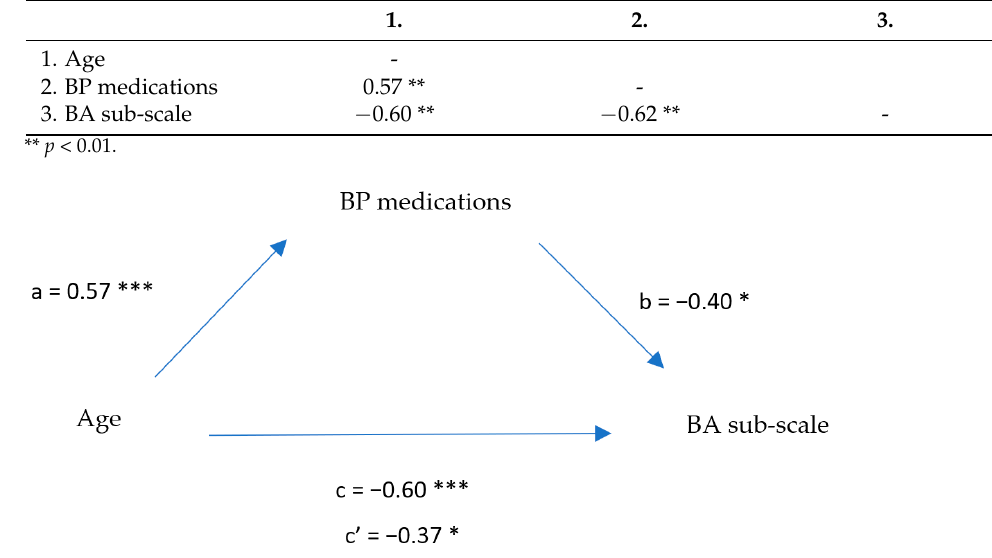
Figure 2. Partial mediation model: BP medications as a mediator in the relationship between age and body awareness (BA) sub-scale. * p < 0.05. *** p < 0.001. BP medications variable was encoded as dummy variable (0 = no usage, 1 = use of BP medications).